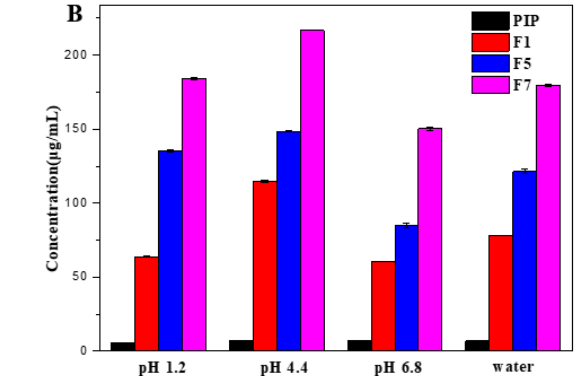
crocapsules (F1, F5, and F7) in different media. capsules (F1, F5, and F7) in different